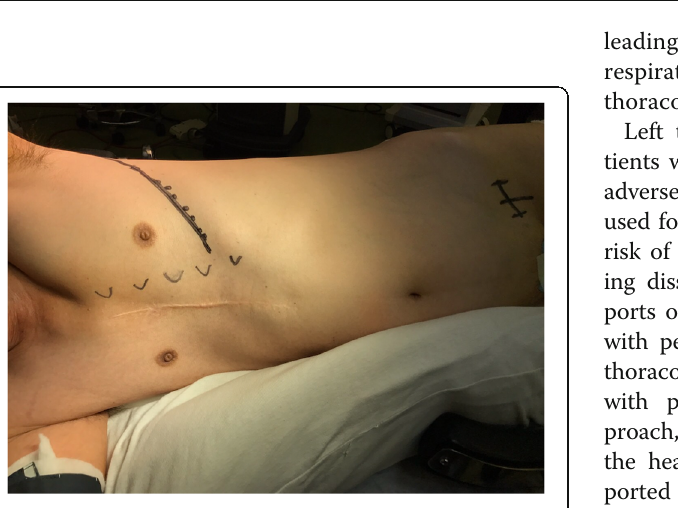
Fig. 3 Operative position view of semi right lateral decubitus position. The picture shows deformation of the thorax around the